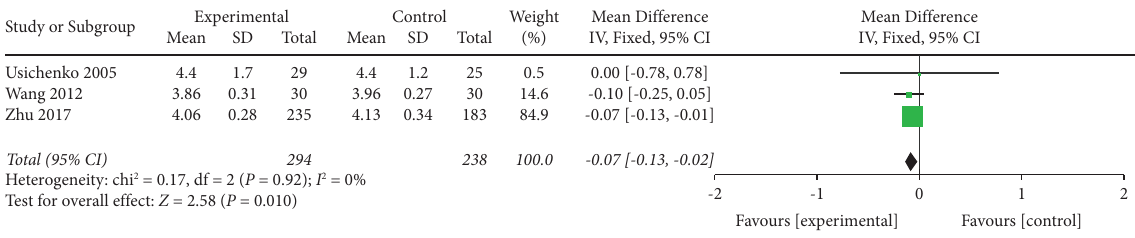
Figure 6: Comparison of the VAS at 36h between the AA group and the control group.